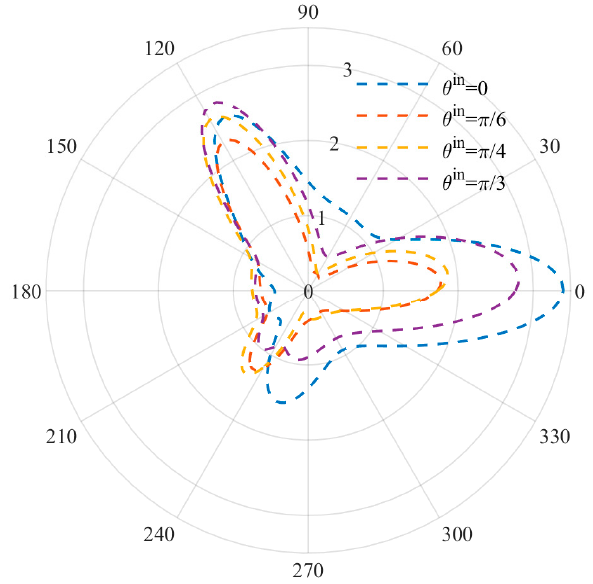
Figure 8. Distribution diagram of DSCF at different incident angles ( ka = 2).